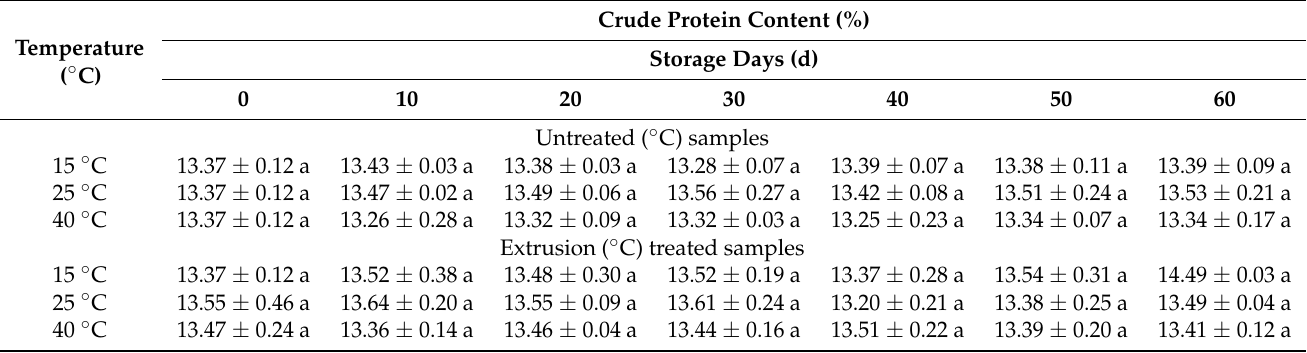
Table 4. Changes in crude protein content in untreated and extruded rice bran during